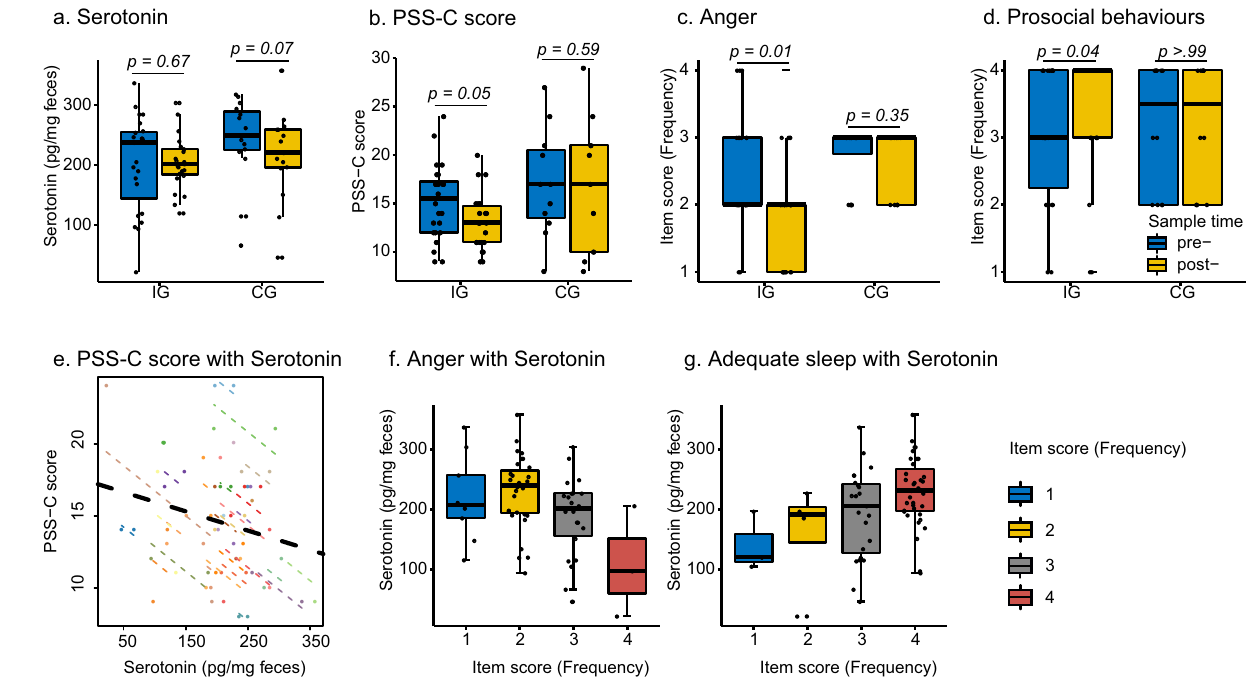
Figure 2. Change in serotonin and child psychosocial measurements. ( a ) Change in fecal serotonin between IG (n = 23) and CG (n = 15), pre- and post-intervention. ( b ) Change in PSS-C score in child psychosocial measurements between IG (n = 20) and CG (n = 9). ( c ) Change in score of anger in child psychosocial measurements between IG (n = 24) and CG (n = 12). ( d ) Change in score of prosocial in child psychosocial measurements between IG (n = 24) and CG (n = 12). ( e ) Association between serotonin and PSS-C score. ( f ) Association between serotonin and anger frequency. ( g ) Association between serotonin and adequate sleep. In ( a ) to ( d ) blue colour indicated pre-samples, yellow colour indicated post-samples. In ( e ), different colour of node and dotted-line indicated different individual, and the black dotted-line indicated the overall association. In ( f ) and ( g ), four colour indicated four degrees of anger and adequate sleep